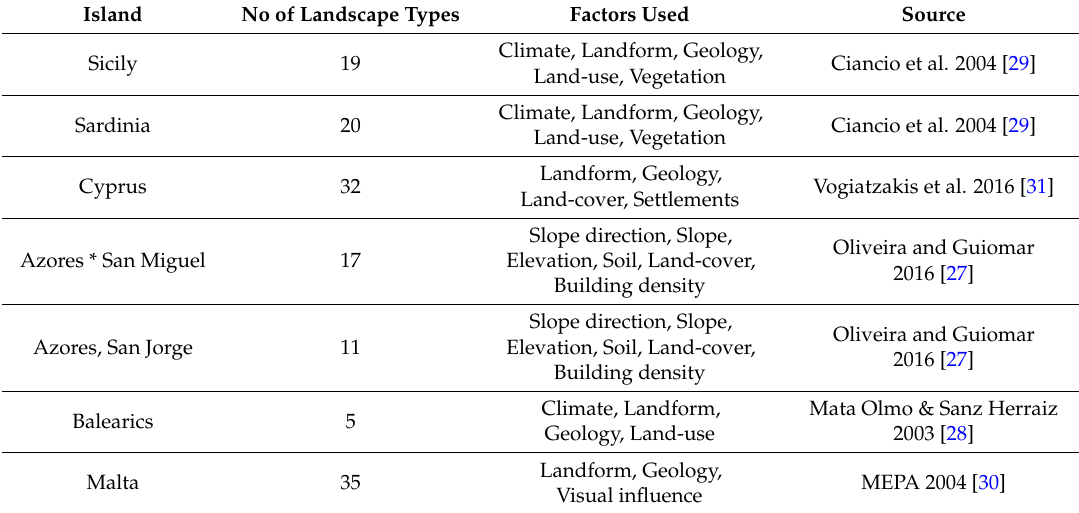
Table 2. Examples of Mediterranean island landscape